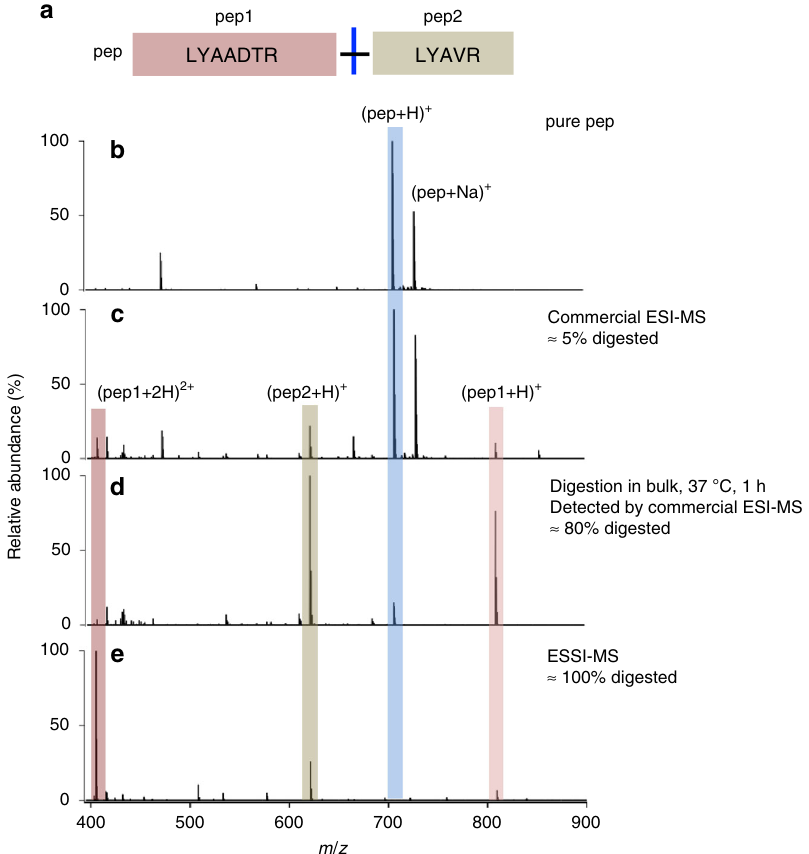
Fig. 6 Trypsin digestion of a synthetic peptide with various methods. a Peptide sequence, b mass spectrum of pure peptide. Mass spectra of the peptide digested with c commercial ESI-MS, d in bulk phase at 37 °C for 1 h, followed by analysis with commercial ESI-MS, and e ESSI-MS applied with a high voltage ( + 3